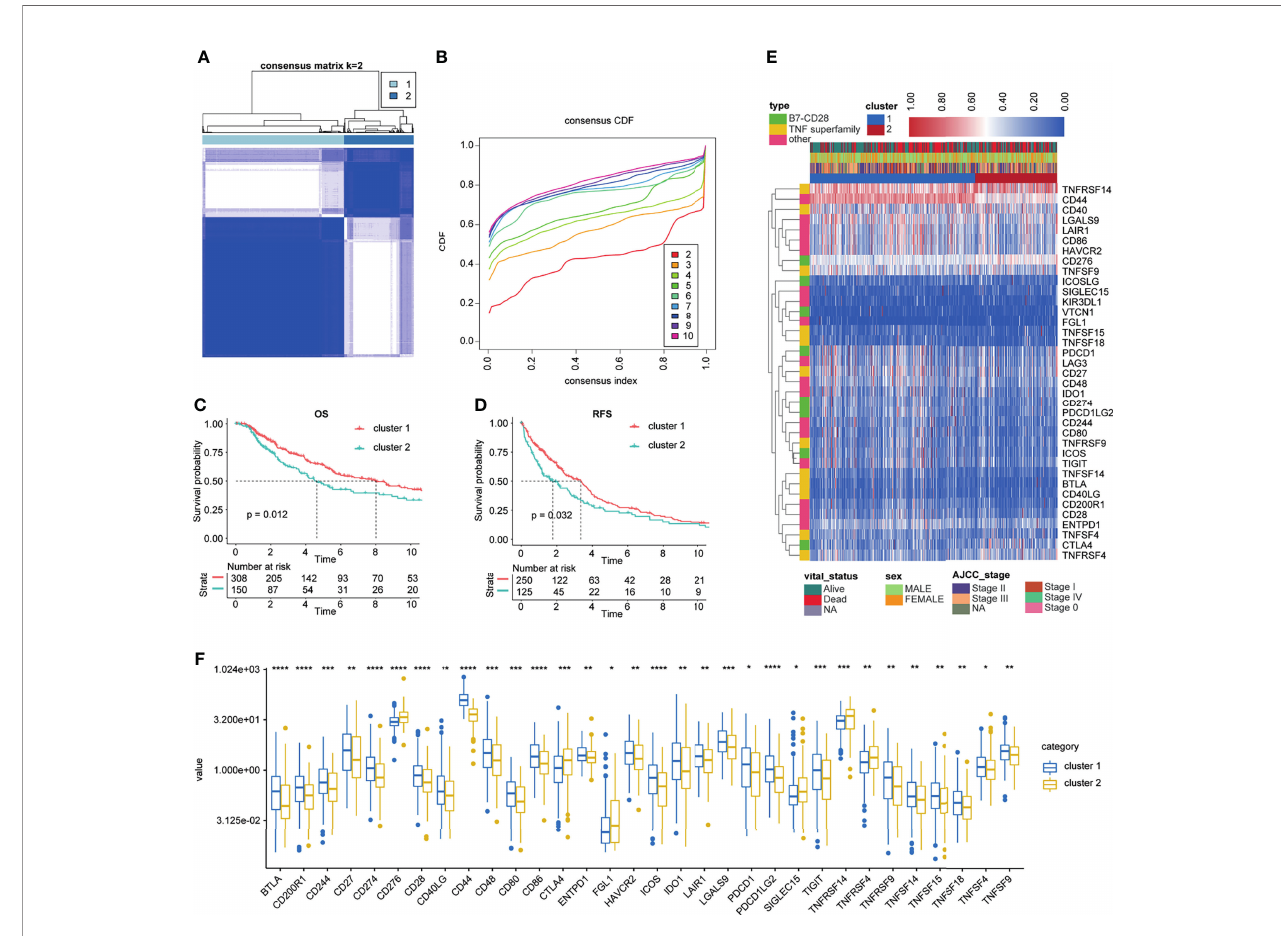
FIGURE 3 | Unsupervised clustering for ICPs. (A, B) Classi fi cation of TCGA-SKCM into two groups. (C, D) Kaplan – Meier curves of OS and RFS in the training cohort based on clustering. (E) Landscape of the expression of 34 ICPs in the TCGA-SKCM set. (F) The 34 ICPs are signi fi cantly differentially expressed between the two clusters. *, **, *** and **** represent P < 0.05, P < 0.01, P < 0.001 and P < 0.0001,